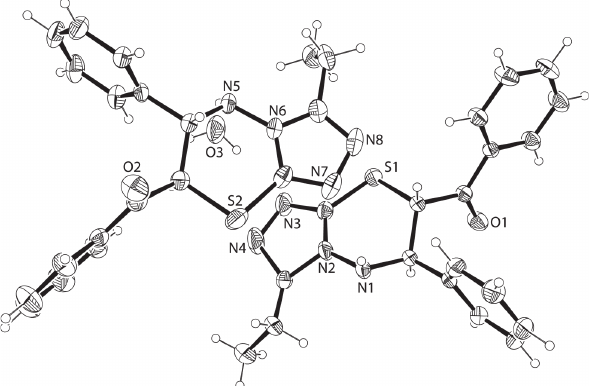
Table 2: Fractional atomic coordinates and isotropic or